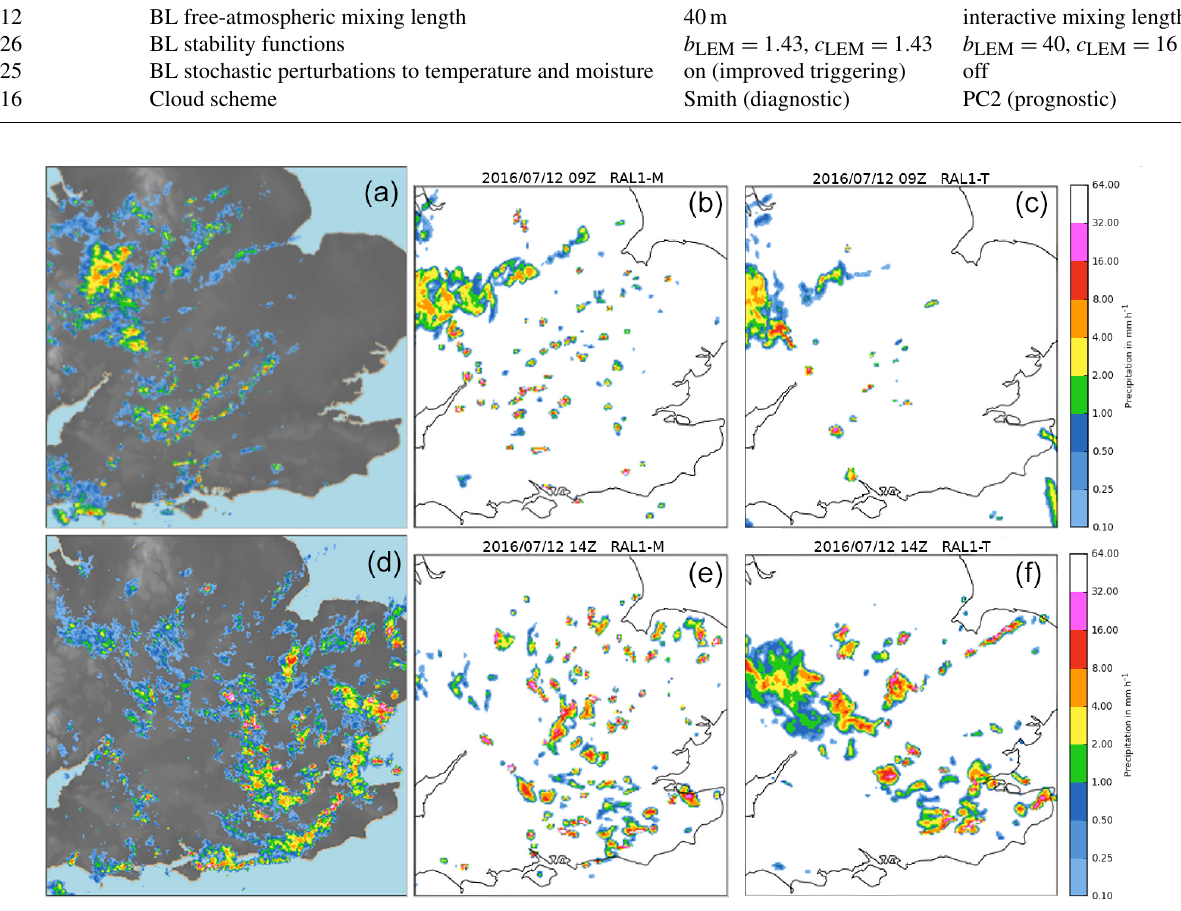
Figure 2. A 12 July 2016 case study showing radar (a, d) , RAL1-M (b, e) and RAL1-T (c, f) at 09:00Z (a, b, c) and 14:00Z (d, e, f) for a case of showers in the